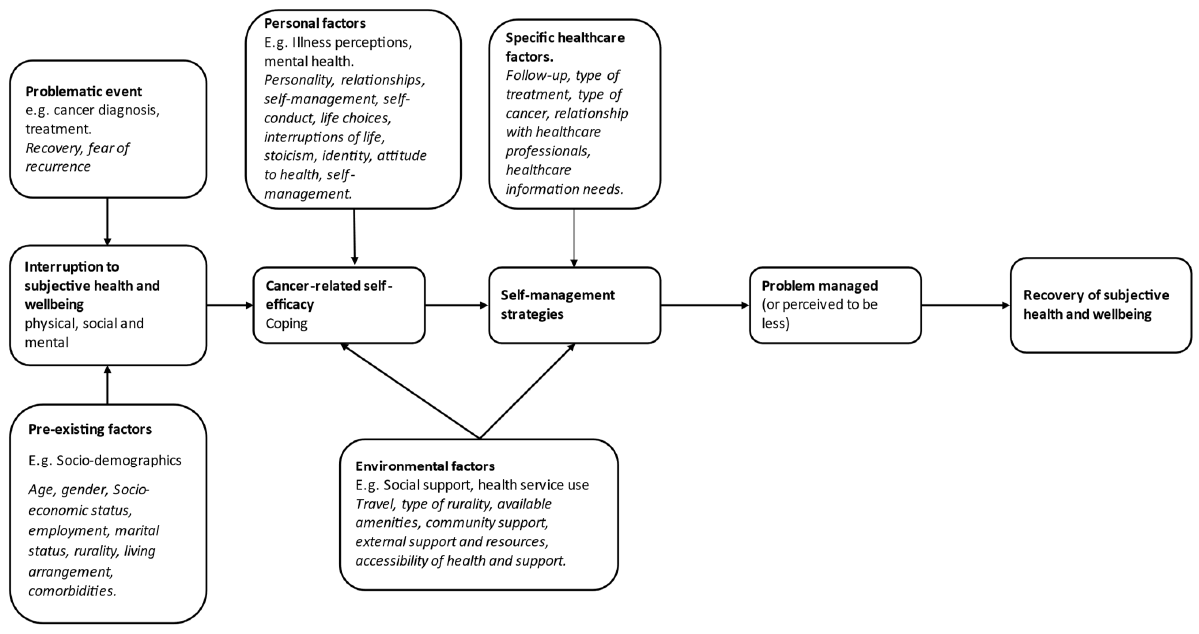
Figure 1. Adapted Framework of Recovery of Health and Wellbeing in Cancer Survivorship, origi- nally by Foster and Fenlon [13].